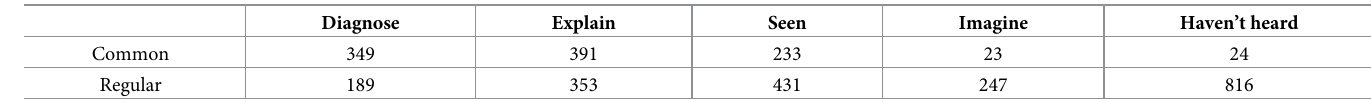
Table 5. Numbers of responses for the two disease categories.